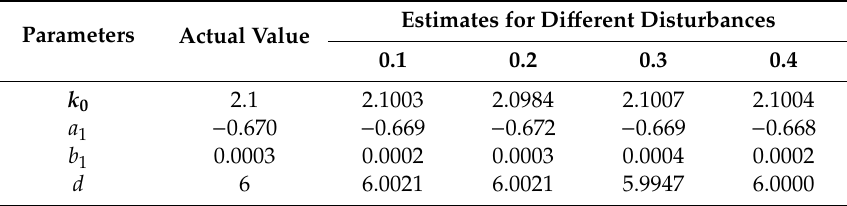
Table 2. Various identification results against interference of